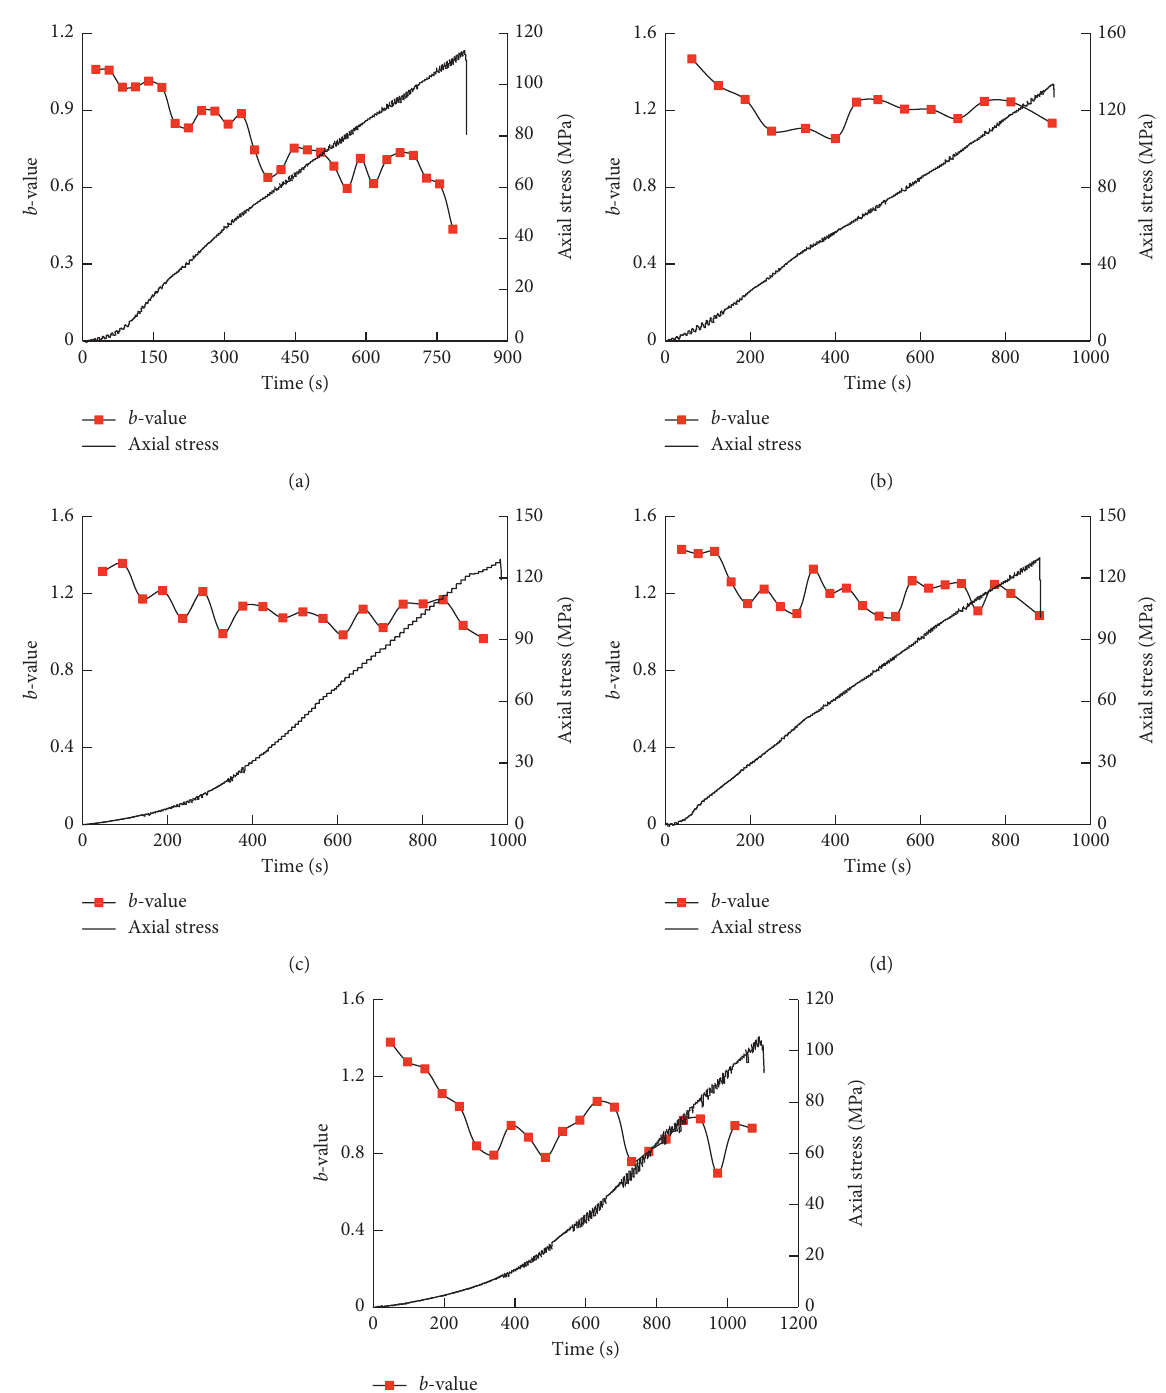
Figure 6: The evolutions of the axial stress and b -value with time for the specimens with orthogonal cracks. (a) 00–90 (b) 30–90 (c)